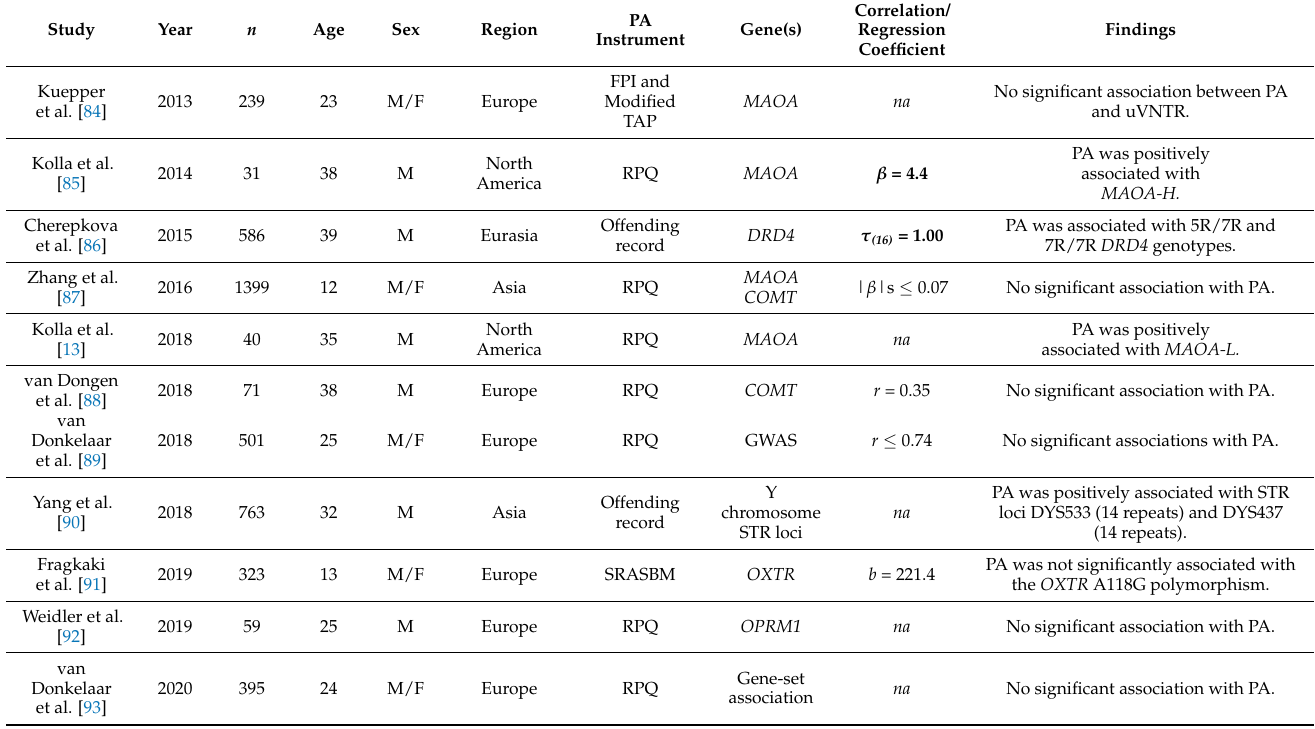
Table 4. Proactive aggression molecular genetic findings according to year of